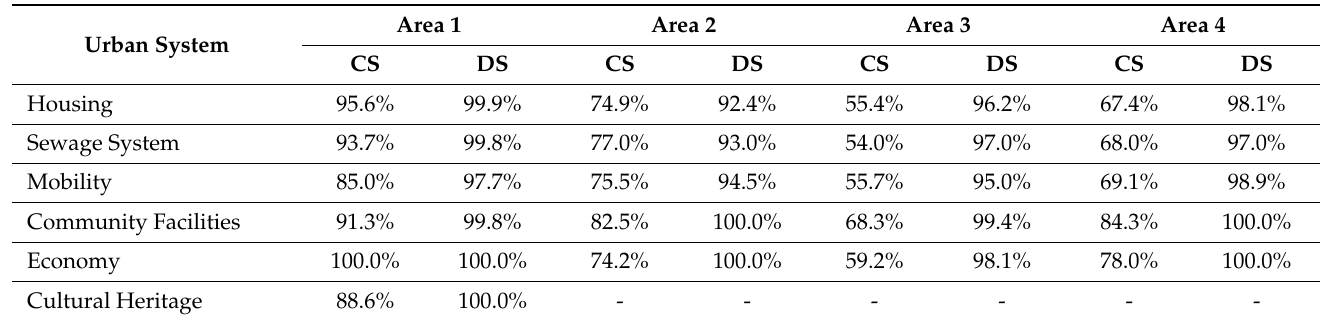
Table 5. Comparison between Current Situation (CS) and Design Scenario (DS)—Results of compre- hensive flood resilience